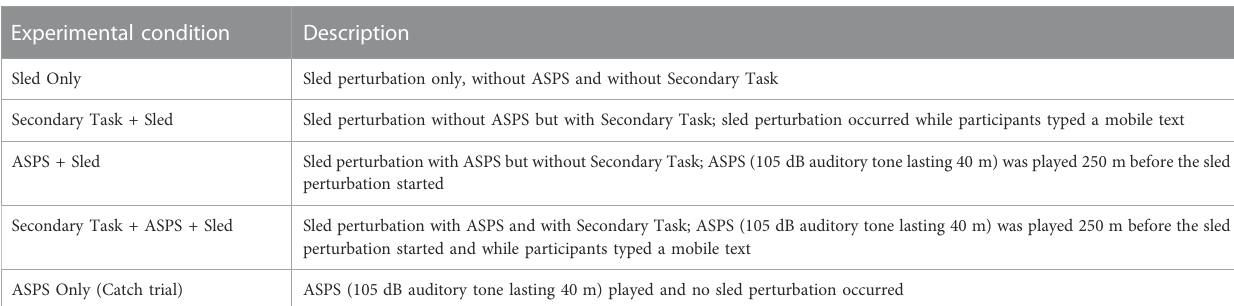
TABLE 2 Testing conditions, repeated twice in a randomized order. Experimental